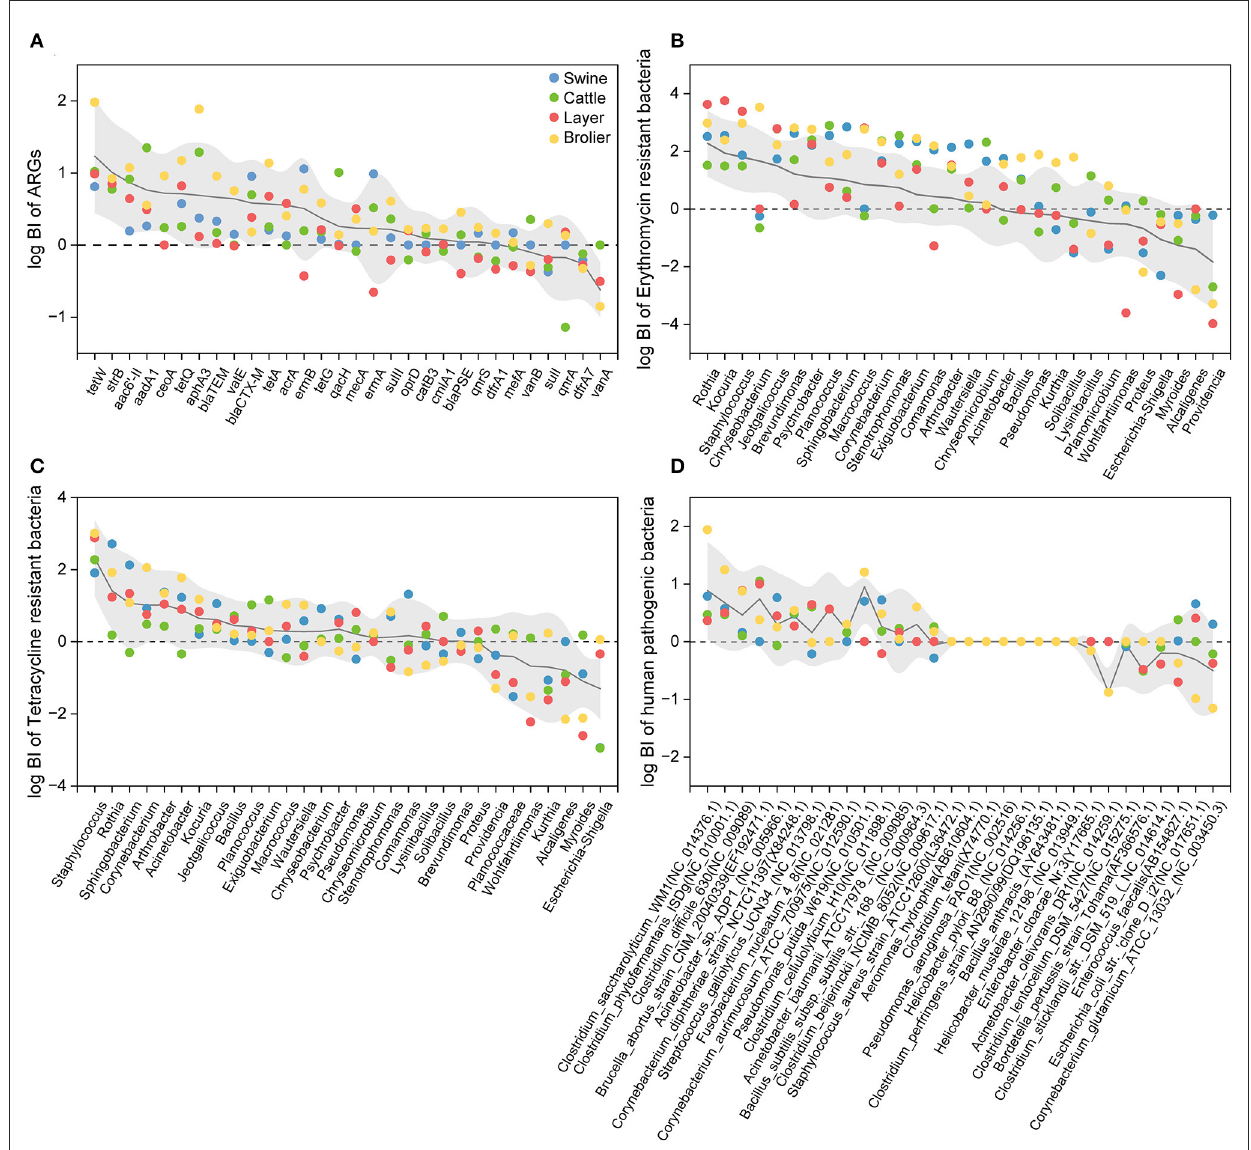
FIGURE4 Bioaerosolization index (BI) of top 30 bacterial genera of ARGs (A) , erythromycin- (B) and tetracycline-resistant bacterial genera (C) , and top 30 human pathogenic bacteria (D) . The BI value was log-transformed.